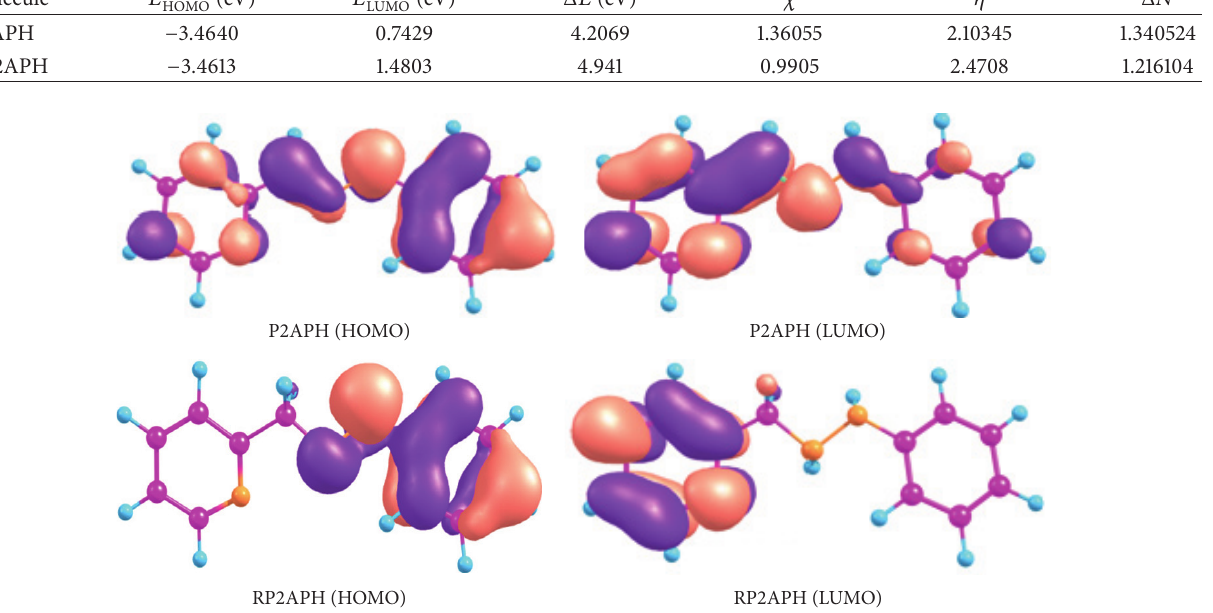
Figure 9: HOMO and LUMO of P2APH and